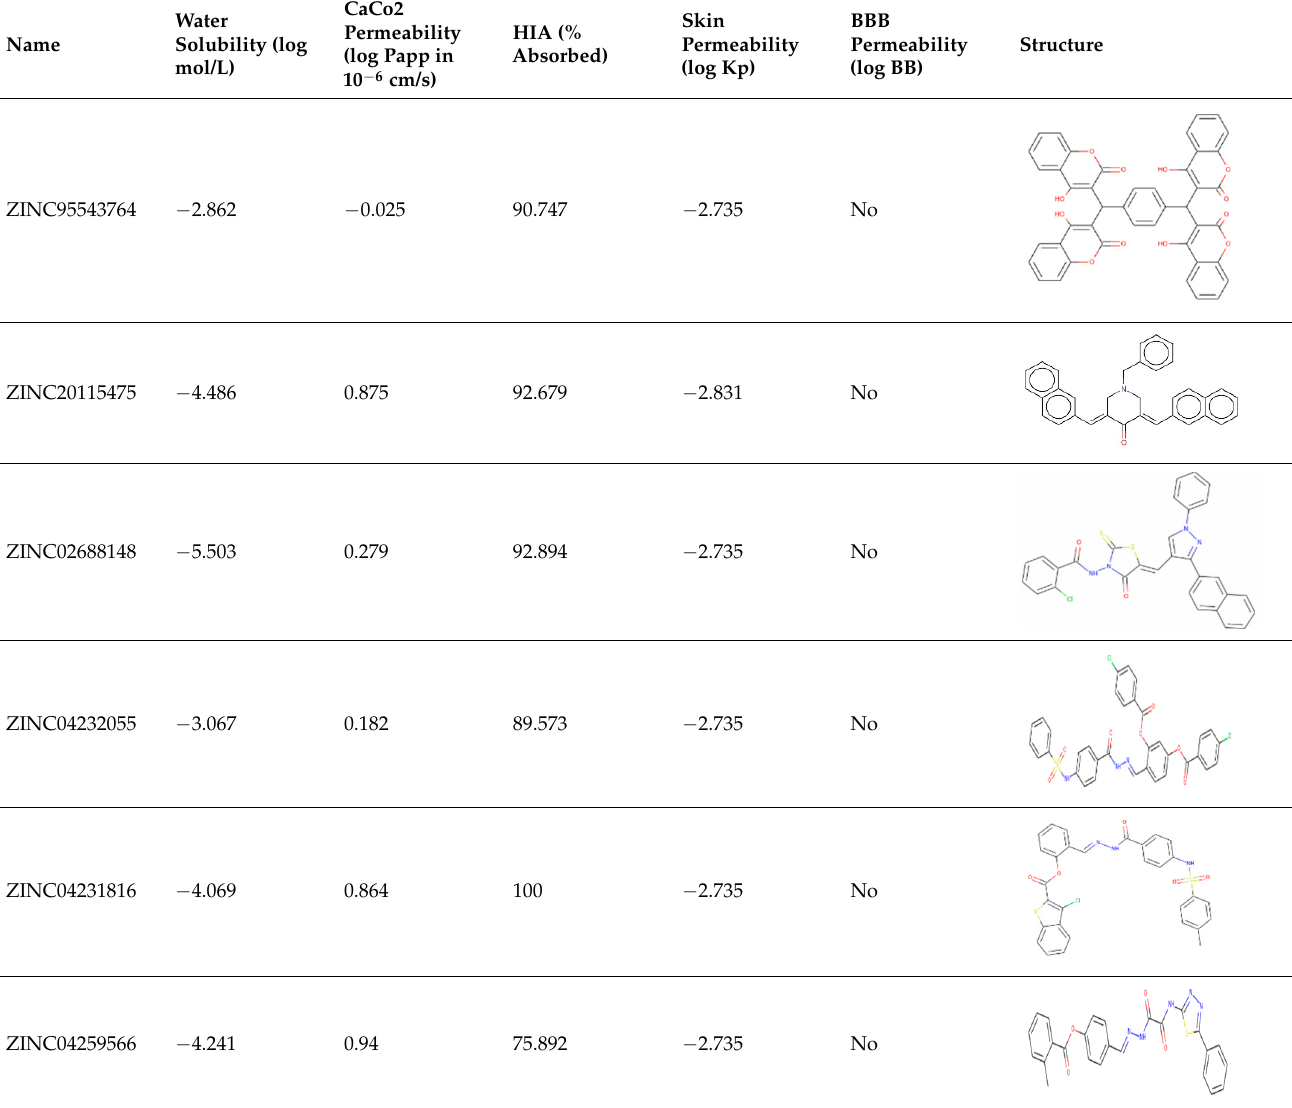
Table 4. ADMET profiling for shortlisted compounds.